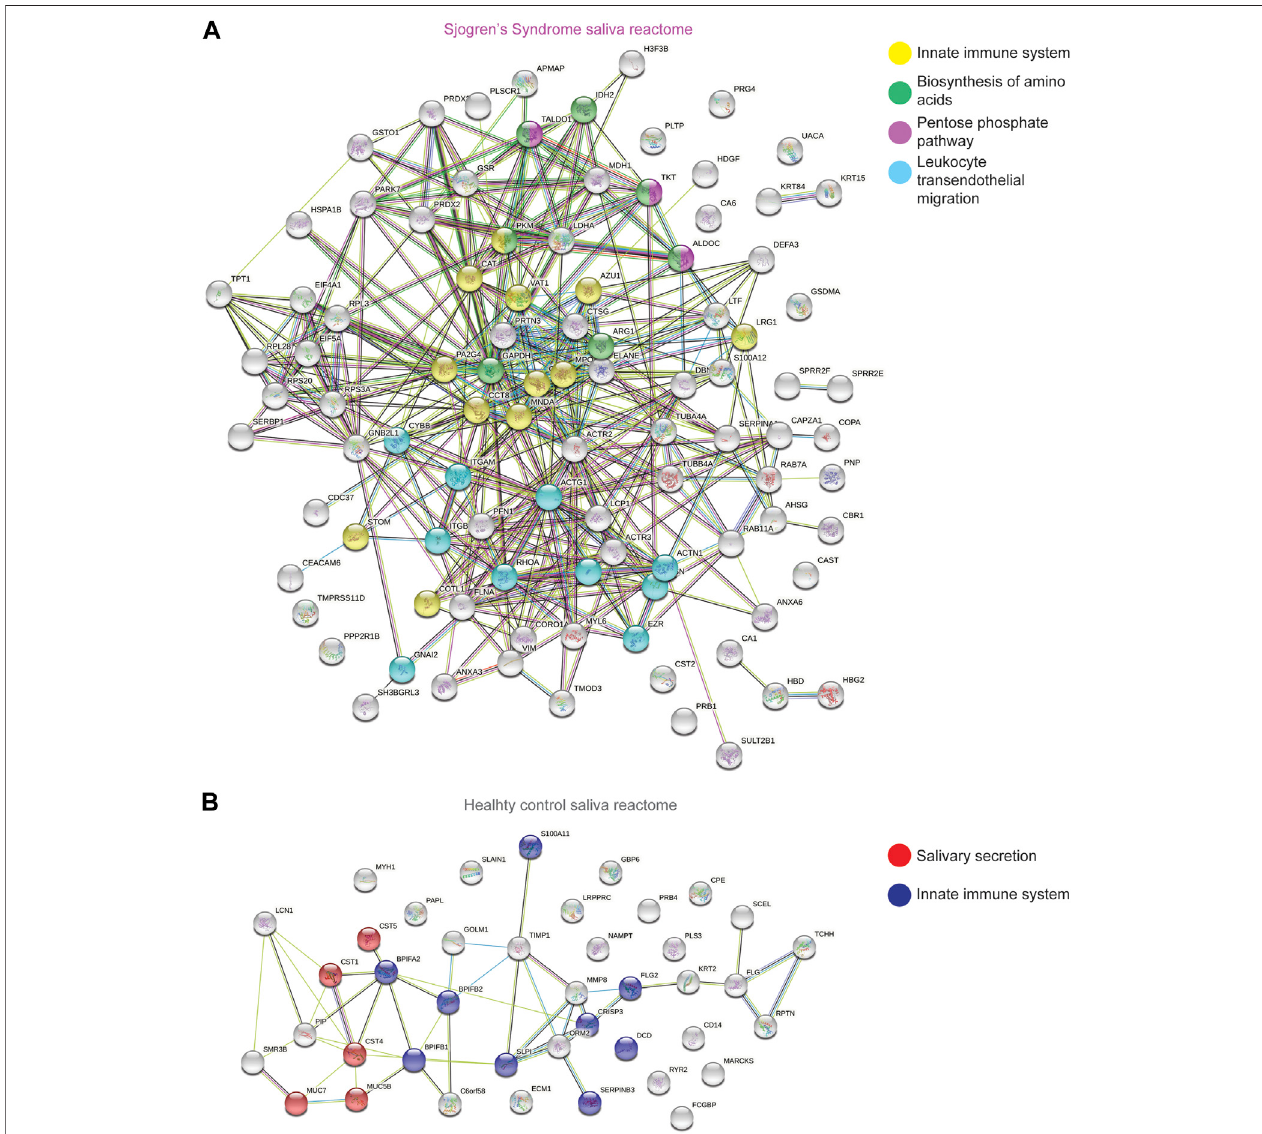
FIGURE 5 | STRING Analysis of Quantitative Proteomics Data of Human Sjogren ’ s Syndrome Saliva Samples. Analysis of protein − protein interaction network by STRING v11. Elevated proteins from (A) SS or (B) healthy control saliva samples identi fi ed from the quantitative proteomics analysis were mapped by searching the STRING v11 software with a con fi dence level of 1% false discovery rate. Colored lines between the proteins indicate different types of interaction evidence: known interactions (teal), experimentally determined (pink), predicted interactions gene neighborhood (green), gene fusions (red), gene co-occurrence (blue), text-mining (yellow), coexpression (black), protein homology